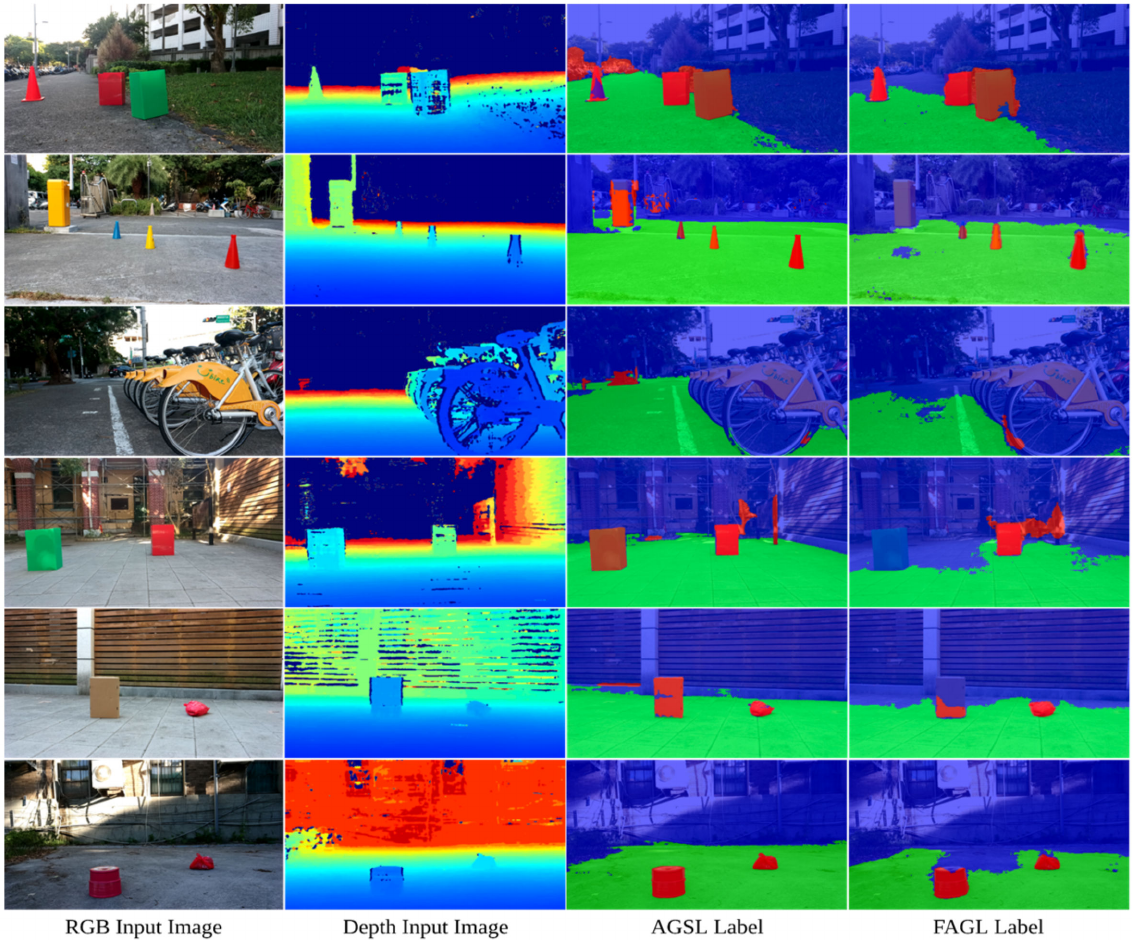
Figure 6. Evaluation of AGSL labels and FAGL labels (FuseNet trained on the AGSL labels) on our constructed